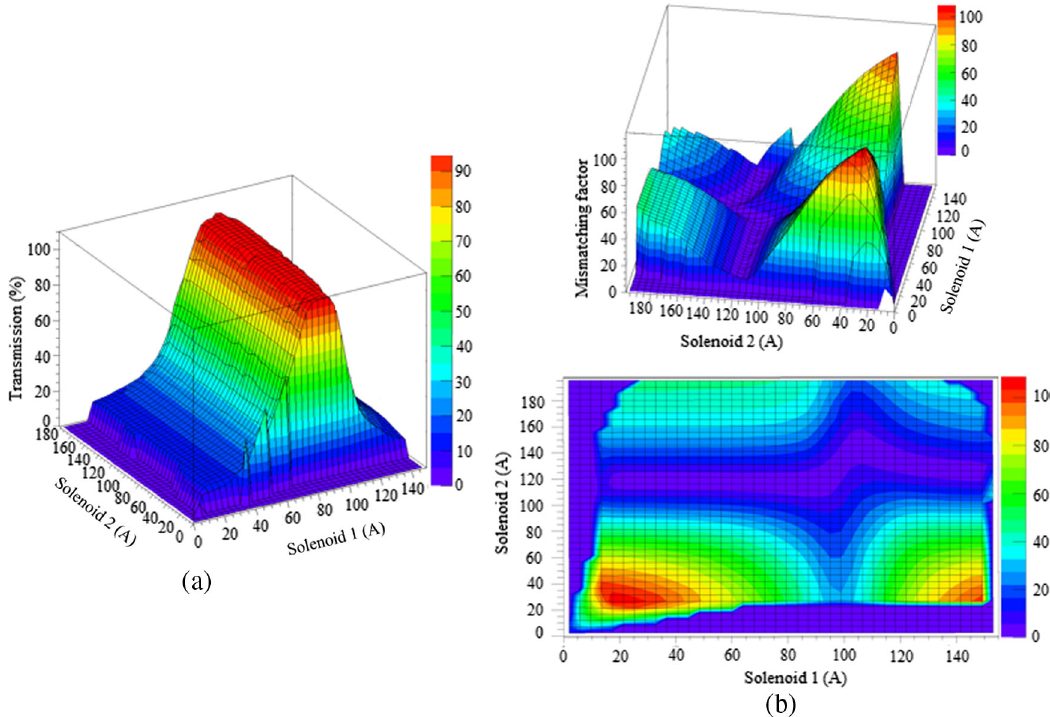
FIG. 3. (a) Beam transmission and (b) (top) mismatching factor to the RFQ ( z axis) as a function of the solenoid magnet 1 strength ( x axis) and solenoid magnet 2 strength ( y axis); (bottom) mismatching factor is color coded. The space charge effect considered the full current at the time of the beam commissioning (15 mA).